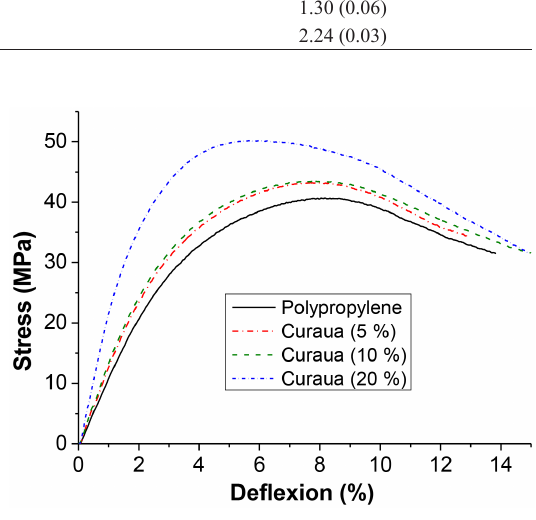
Figure 4. Average stress deflexion curves of polypropylene and